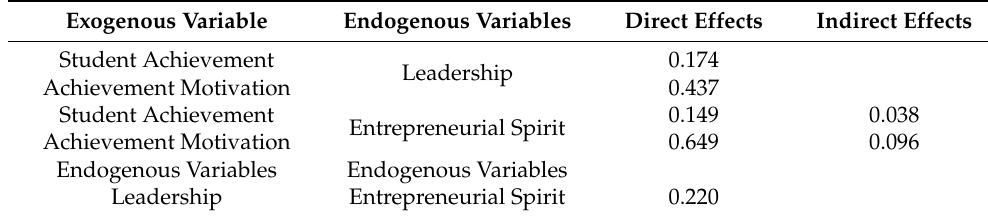
Table 6. Coefficient of structural influence of exogenous and endogenous